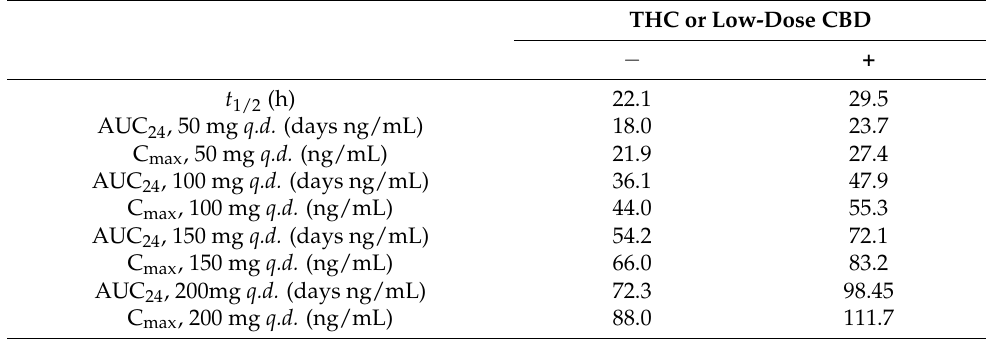
Table 3. Pharmacokinetic parameters at steady state for a model sertraline normal metabolizer with concurrent cannabinoid use assuming a 25% reduction in